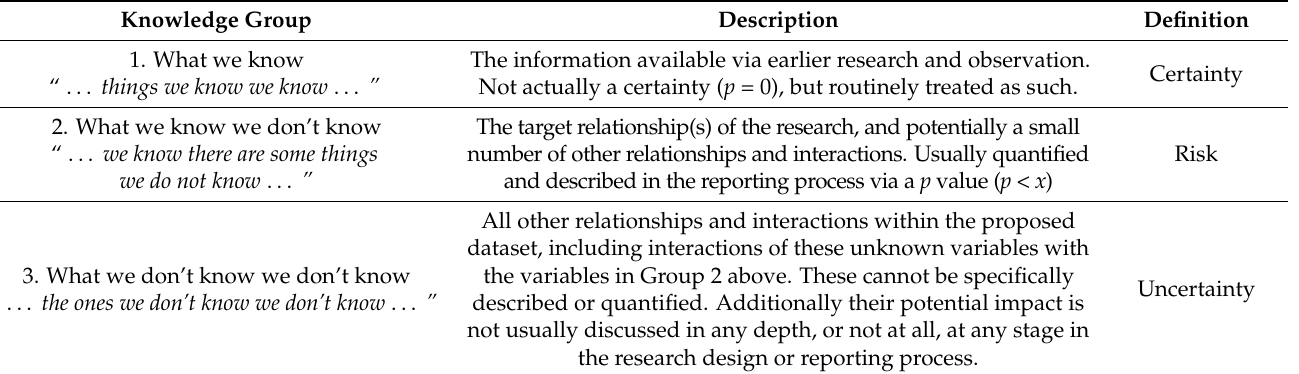
Table 1. The division of knowledge in research design (after Rumsfeldt). Knowledge